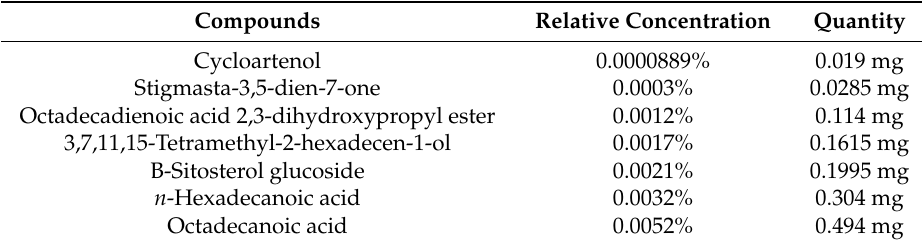
Table 1. Phytochemical analysis of the acetone extract composition. The reported relative concentration corresponds to 1 g of